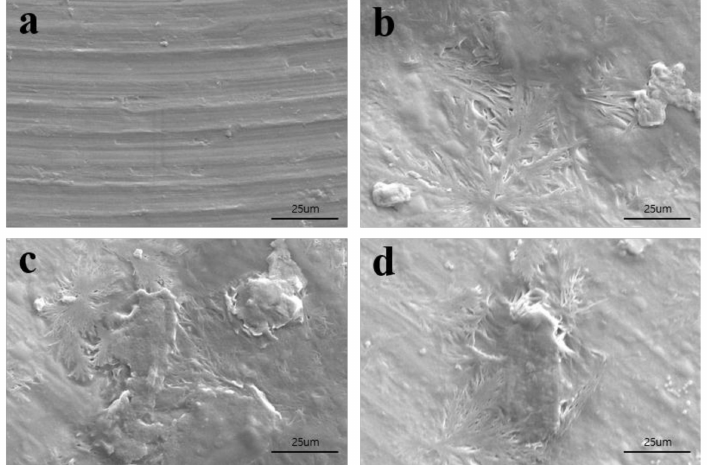
Figure 1. Scanning electron microscopy (SEM) images of each group: ( a ) control, ( b ) GA, ( c ) 10 kGy, and ( d ) 25 kGy ( × 1000 magnification).